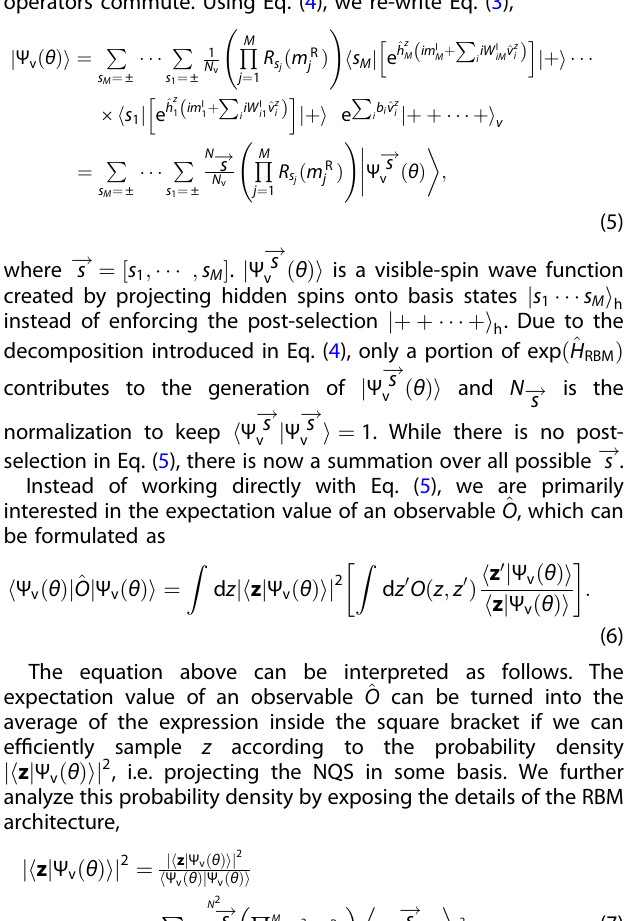
Fig. 1 Quantum circuits for preparing unitary-coupled RBM states. Unitary-coupled RBM-NQS. a Quantum circuit to directly prepare a two- qubit unitary-coupled RBM state having two hidden spins. The inter-layer coupling is mediated by unitary gates. Note θ 0 of the RBM state generated by the quantum circuit in panel a . c Scalable preparation of unitary-coupled RBM state described in Eqs. (3) – (5). A sample circuit in which the hidden spins are projected onto þ(cid:3)j i is